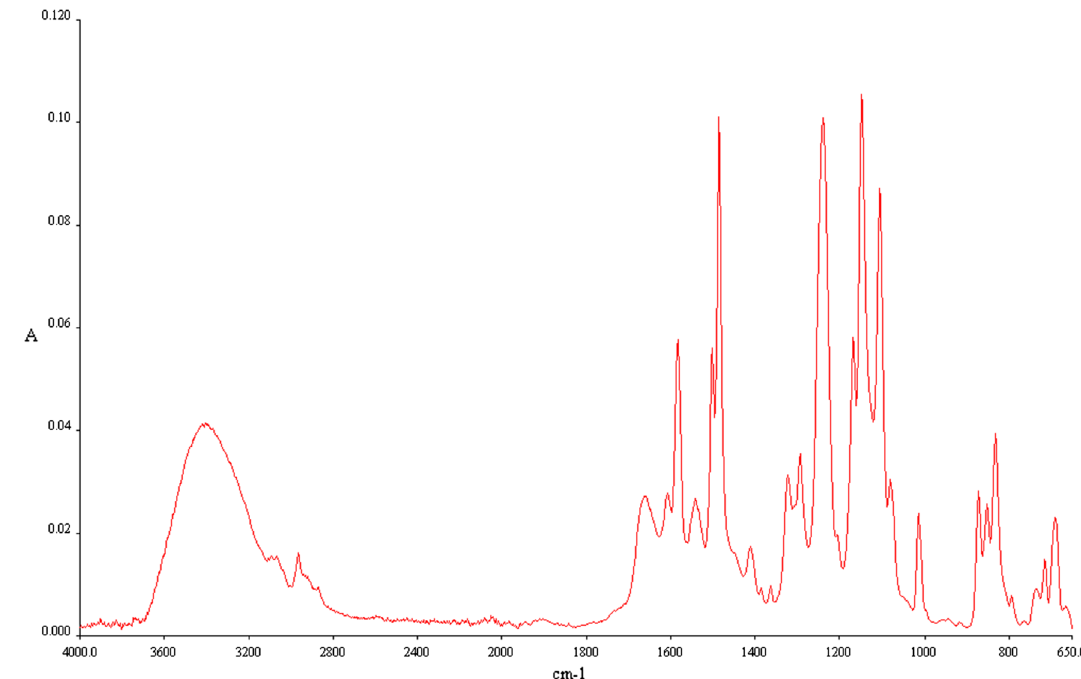
Fig. 1 FTIR spectra of the virgin Koch membrane